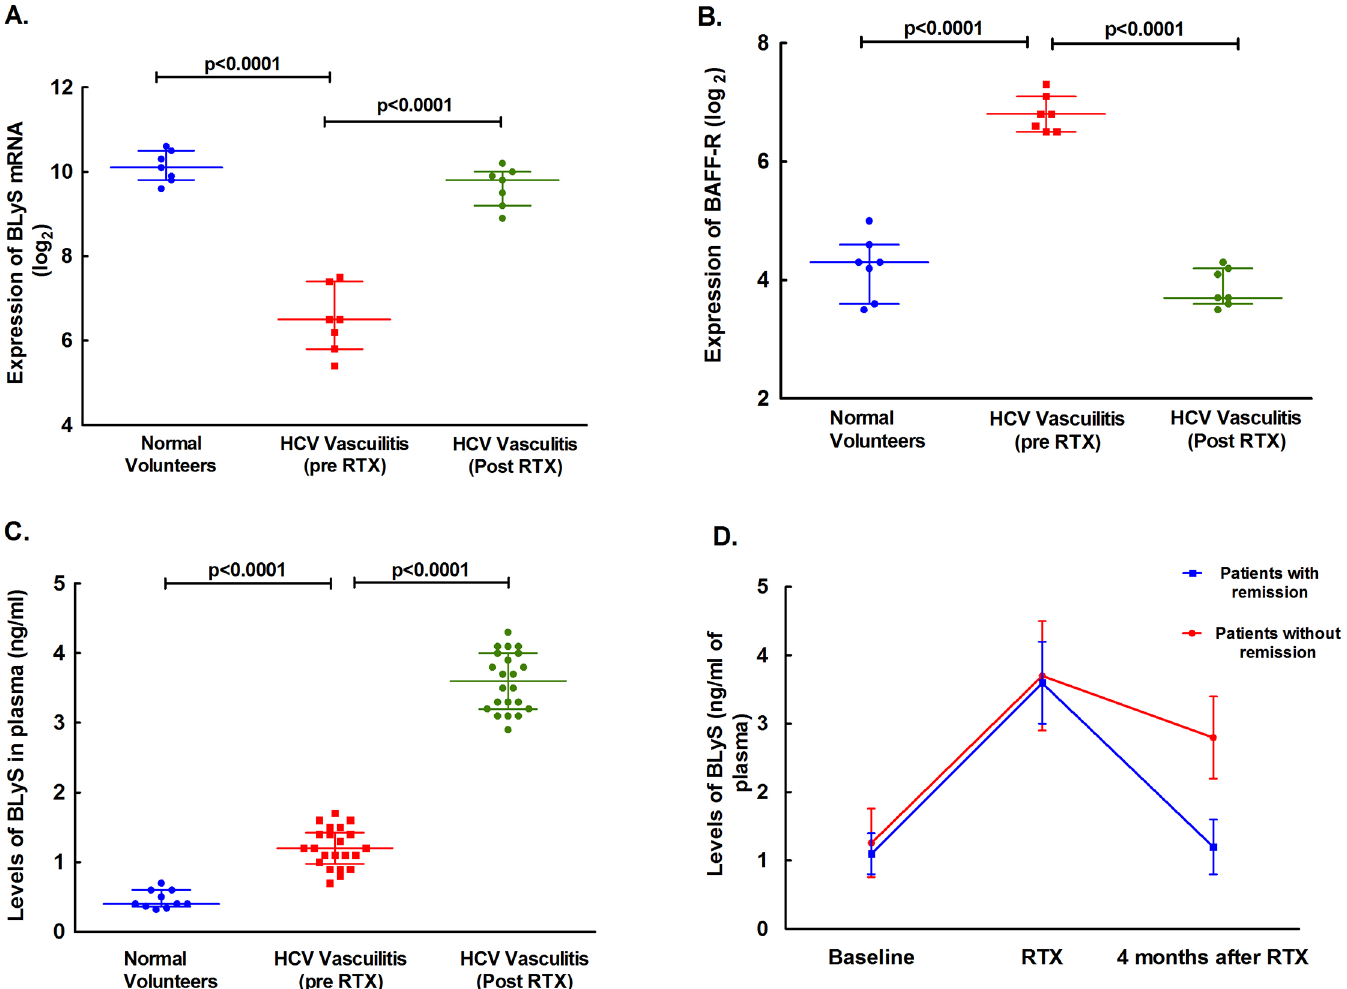
Fig 3. Regulation of BLyS and receptor expressionof protein levels with Rituximab (RTX) treatment. As shown in 3A, expressionof BLyS is down regulated in HCV vasculitis patients as comparedto normalvolunteers(p < 0.0001), but is upregulatedafter RTX treatment (p < 0.0001). BAFF-R expressionis upregulated in HCV vasculitis patients as comparedto normalvolunteers(p < 0.0001), but down regulatedafter RTX treatment (p < 0.0001) in 3B. In 3C, levels of BLyS are upregulatedin patients with HCV vasculitis as comparedto normalvolunteers(p < 0.0001), but are even further upregulatedafter treatment with RTX (p < 0.0001). In 3D, paradoxically BLyS levels remain elevatedin relapsedpatients who achieveremission4 months after RTX therapy.